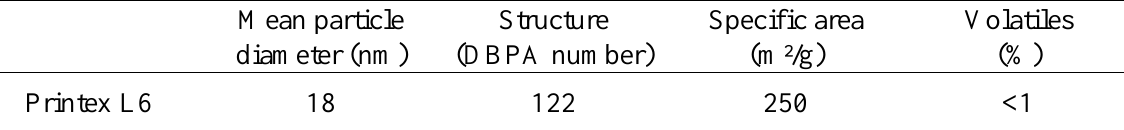
Table 1. Main characteristics of carbon black filler particles.